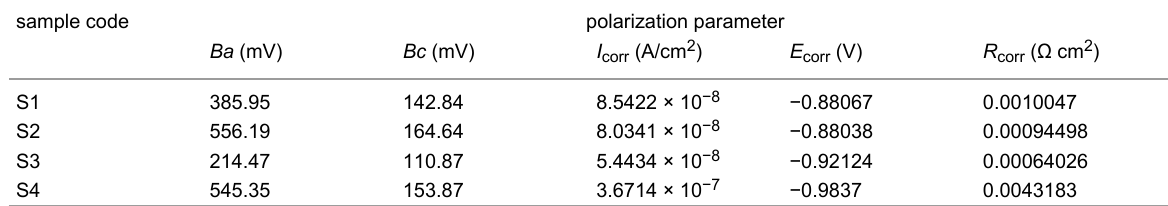
Table 4: Polarization parameters of the prepared samples. a